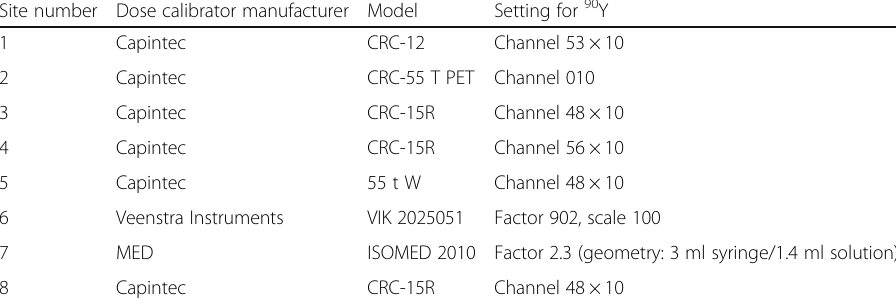
that reported on shipping